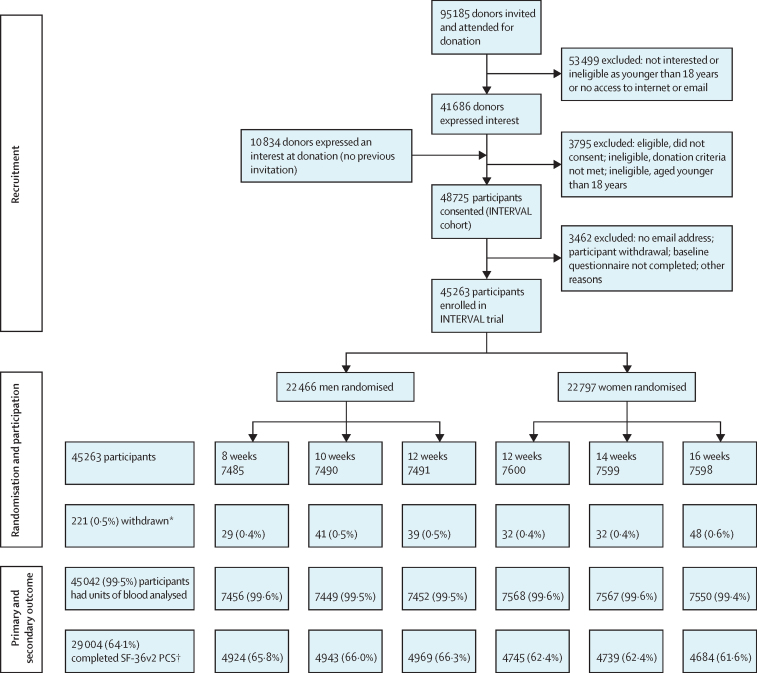
Trial profileCONSORT flowchart showing recruitment, participation, and completeness of main outcomes. *Participants withdrew permission to use their data. †Physical wellbeing at 2 years was measured with the physical component score (PCS) of the 36-item Short Form Health Survey, version 2 (SF-36v2).